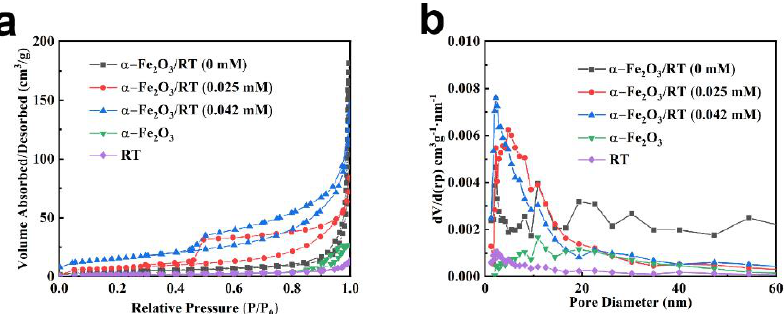
Figure 7. ( a ) N 2 adsorption/desorption isotherm, ( b ) the corresponding pore size distribution of the α -Fe 2 O 3 /RT (0 mM), α -Fe 2 O 3 /RT (0.025 mM), α -Fe 2 O 3 /RT (0.042 mM), α -Fe 2 O 3 , and RT.